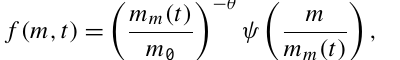
Fig. 11. Statistics of ice crystal number concentrations (top row) and relative humidity wrt ice (bottom row) for different temperature regimes (left: low temperature conditions, middle: medium temperature conditions, right: high temperature conditions).